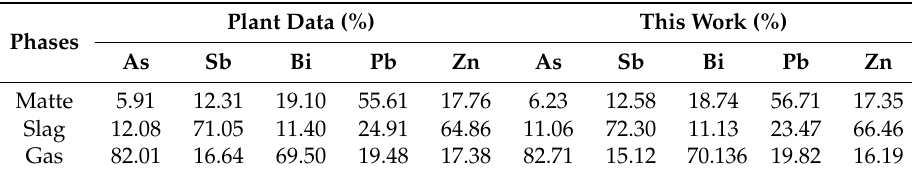
Table 7. Comparison of calculations with actual plant data of the minor elements distributions in the SKS